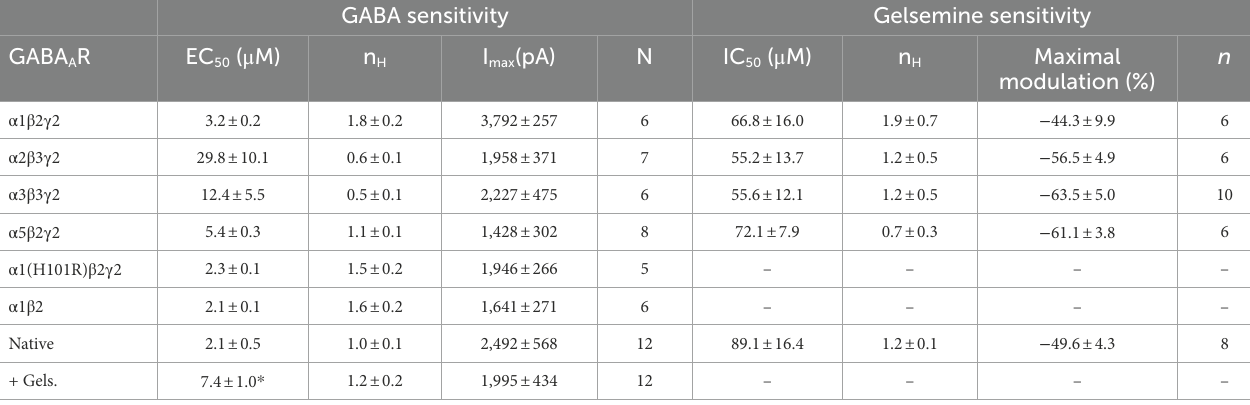
GABA sensitivity